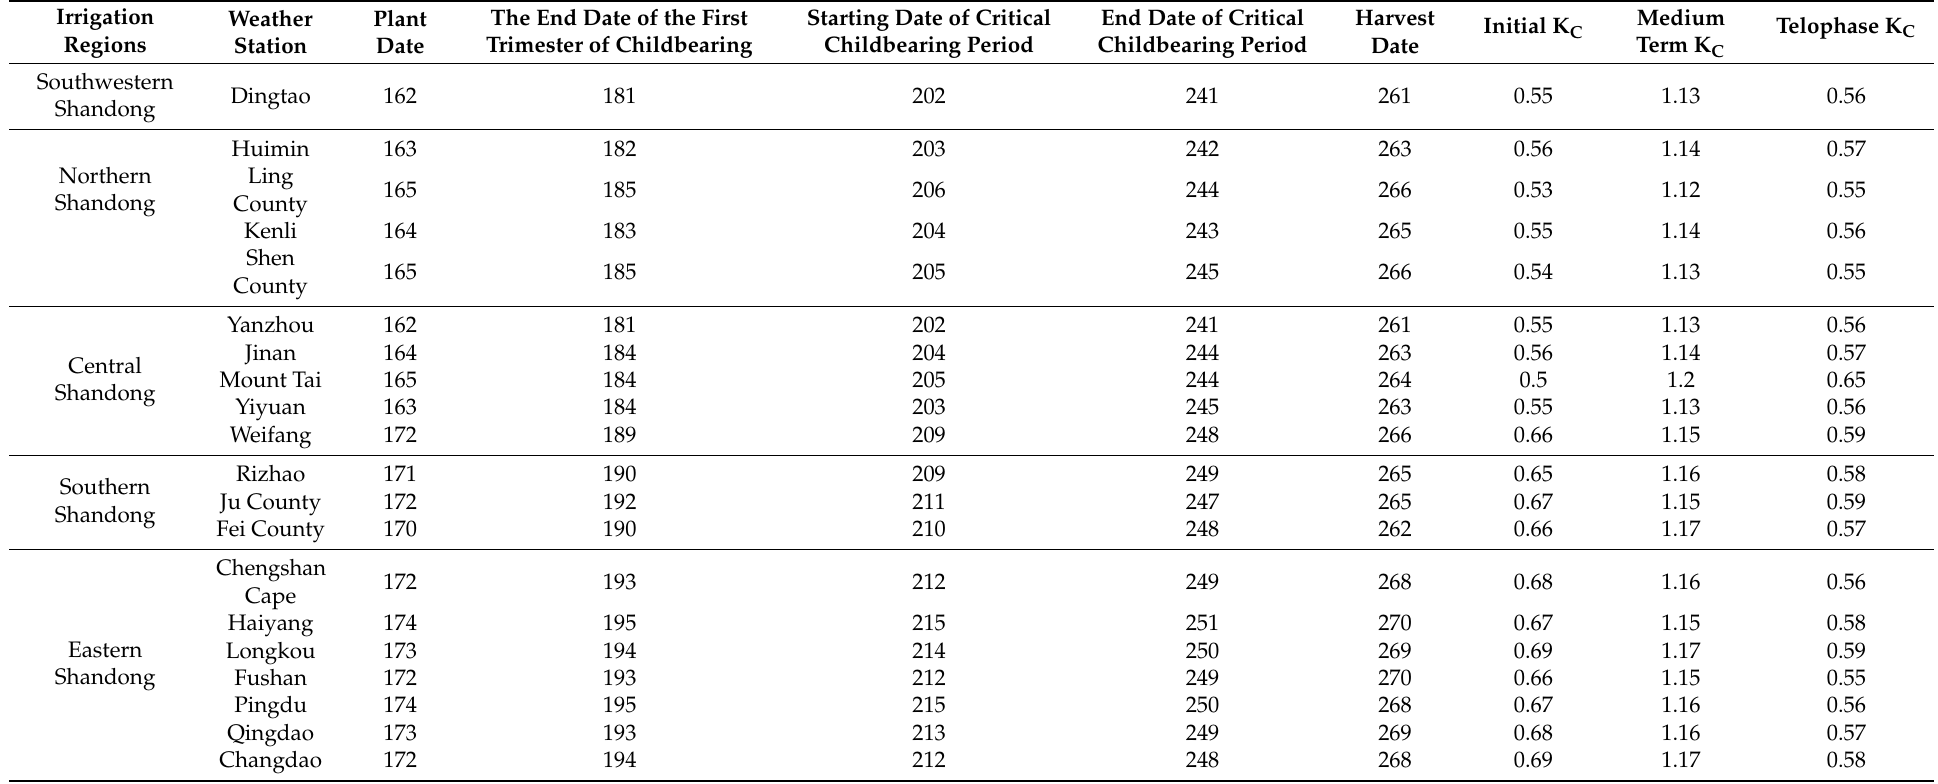
Table A1. Crop coefficients of summer maize as day of the